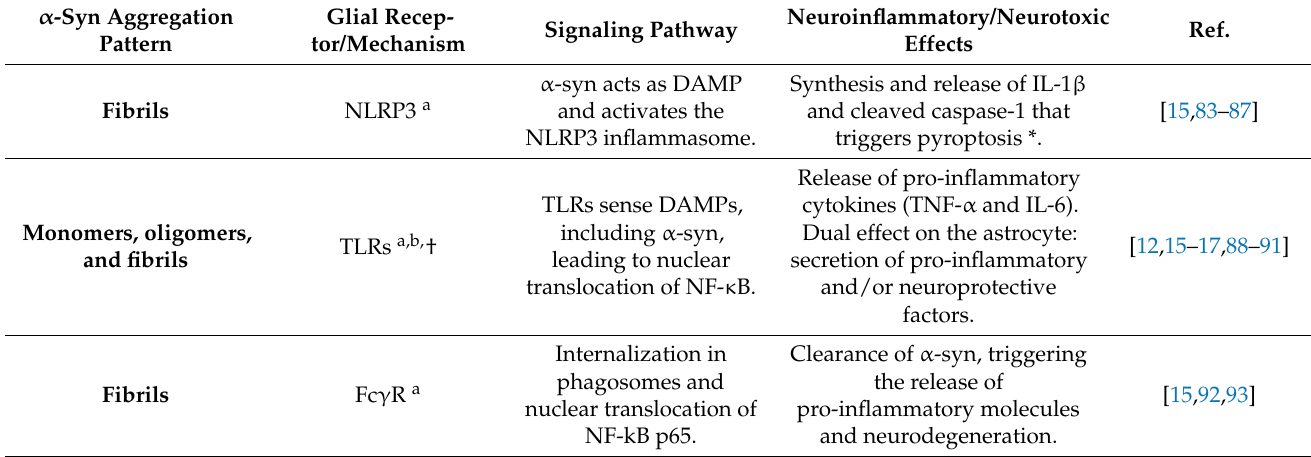
Table 1. Neuroinflammatory and neurotoxic effects triggered by pathological α -syn interaction with glial cells. α -Syn Aggregation